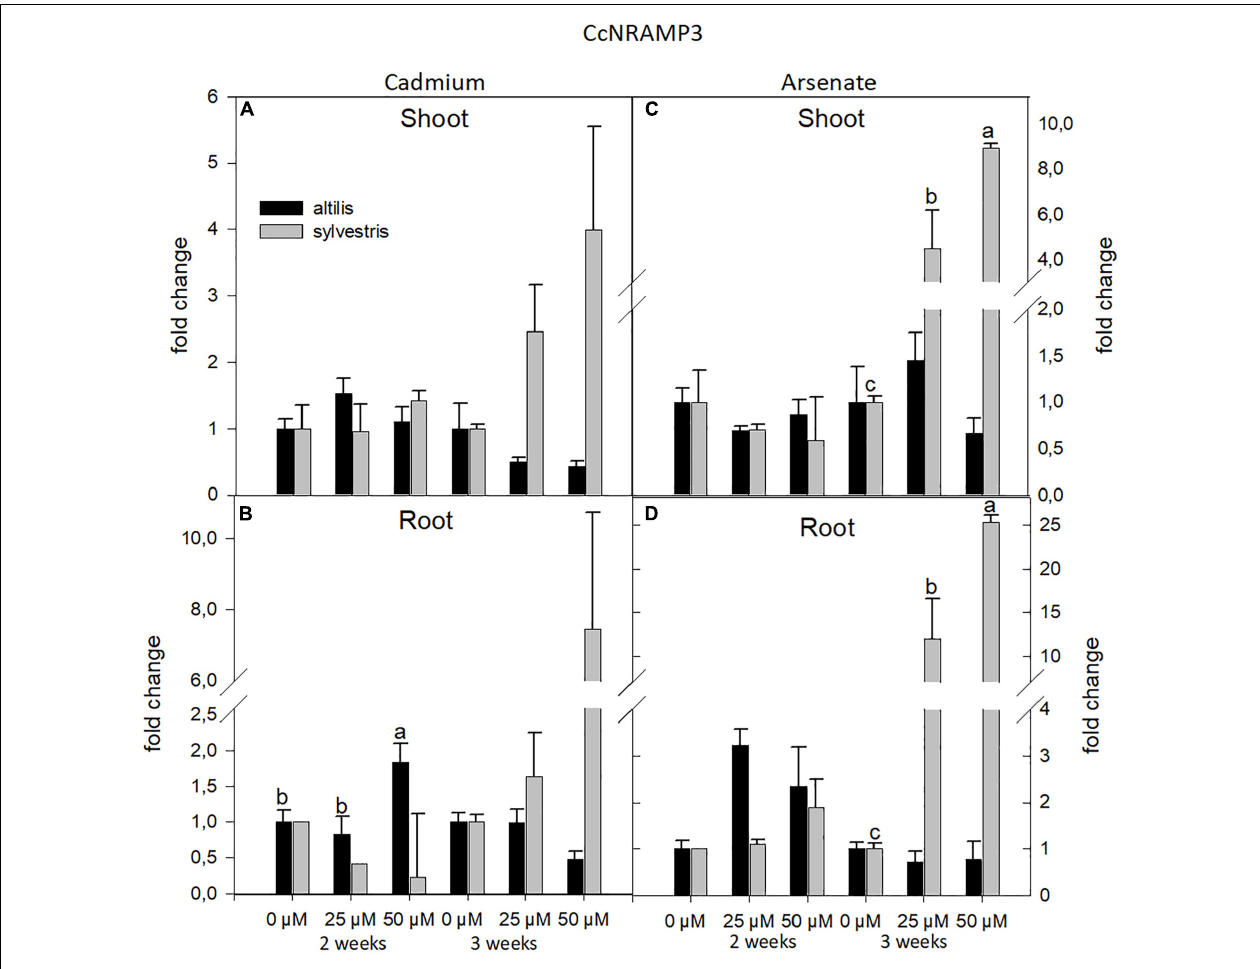
FIGURE 4 | The level of gene expression of NRAMP3 in seedlings of altili s and sylvestris grown up to 2 and 3 weeks under Cd (A,B) and As (C,D) at different concentrations. The fold change is the Ct value with respect to the housekeeping genes (EF1 α and GAPDH) that is considered 1. The error bars represent the error mean of three biological replicates. Letters indicate only significantly different values ( P ≤ 0.05) between concentrations in each moment of sampling.